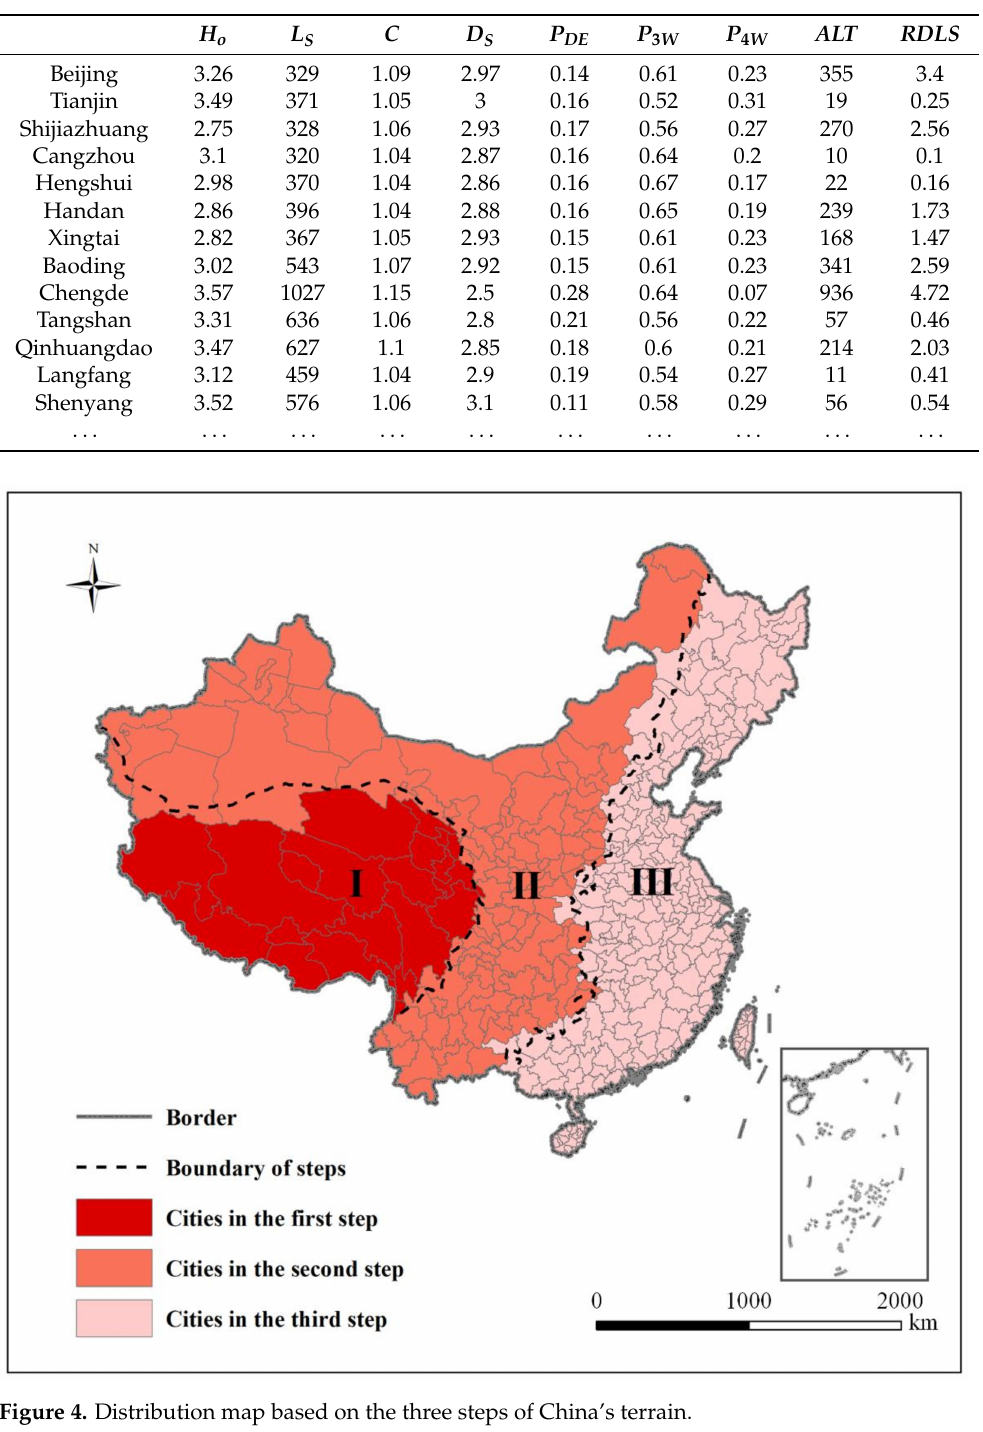
Table 1. Calculation results of each index for prefecture-level cities.